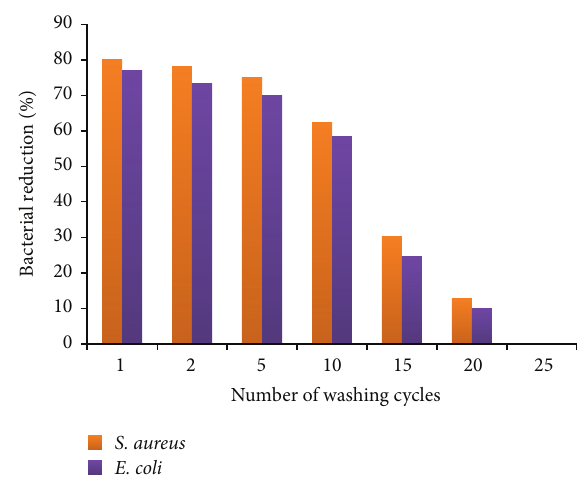
Figure 6: Effect of washing cycles on the antibacterial activity of NiO nanoparticles coated cotton